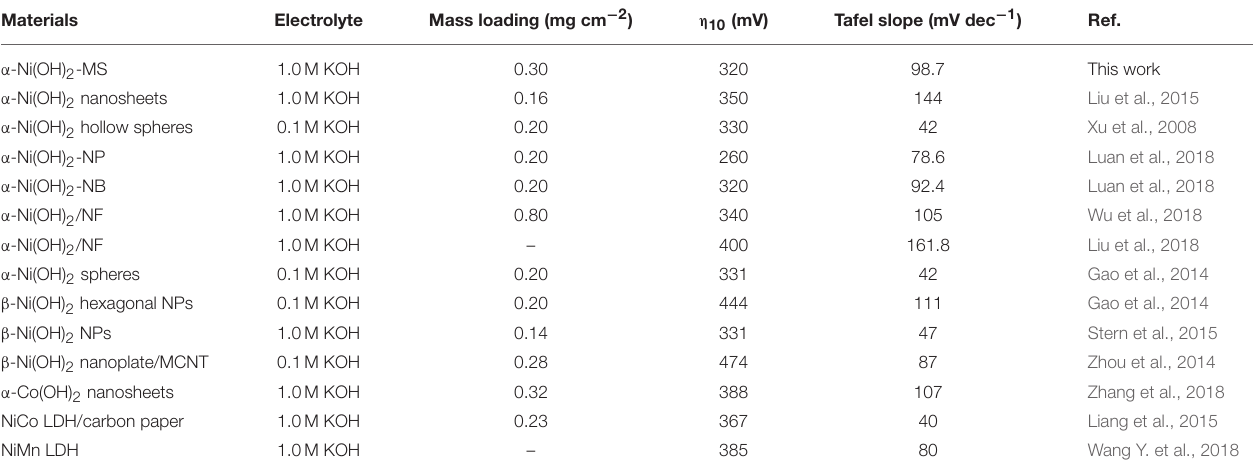
TABLE 2 | Comparison of OER performance of the most typical mono- and bi-metal hydroxide catalysts in alkaline electrolyte.